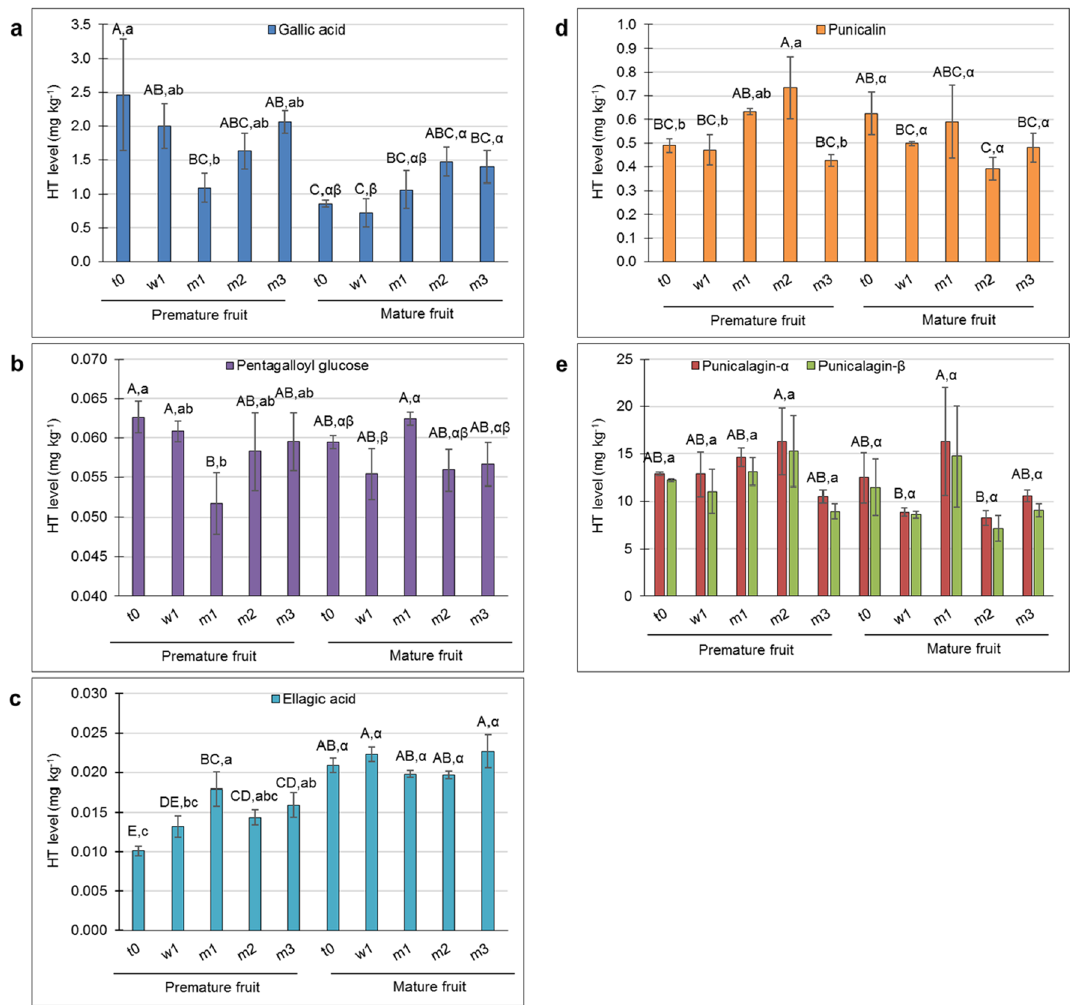
Figure 4. Contents of six members of the hydrolyzable tannins (HT) in the skin of premature and mature fruit at harvest (t0), after 1 week in storage (w1), and after 1, 2 and 3 months in storage (m1, m2, m3, respectively). ( a ) Gallic acid, ( b ) Pentagalloyl glucose, ( c ) Ellagic acid, ( d ) Punicalin, ( e ) Alpha- and beta-Punicalagin. Values are averages of three biological replicates ± SE. Different letters indicate significant differences among means by Student’s t -test ( P < 0.05): uppercase letters for both peel types and all time points, lowercase letters for premature fruit at different time points, and Greek letters for mature fruit at different time